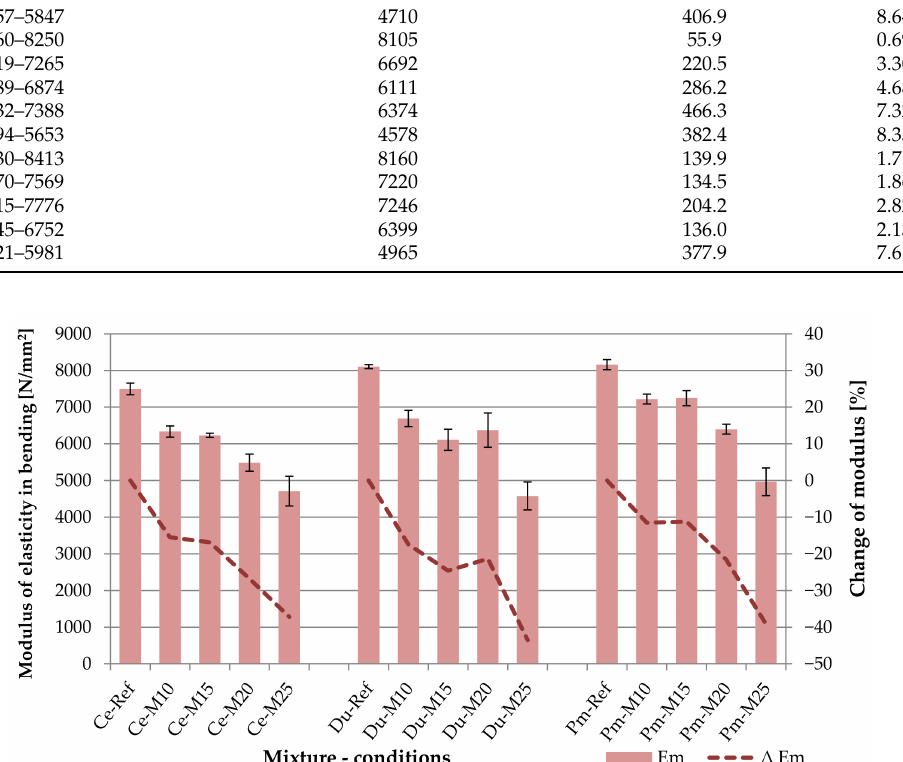
Figure 14. Comparison of modulus of elasticity in bending; columns—modulus of elasticity in bending (E m ), curves—change of modulus of elasticity in bending ( ∆ E m